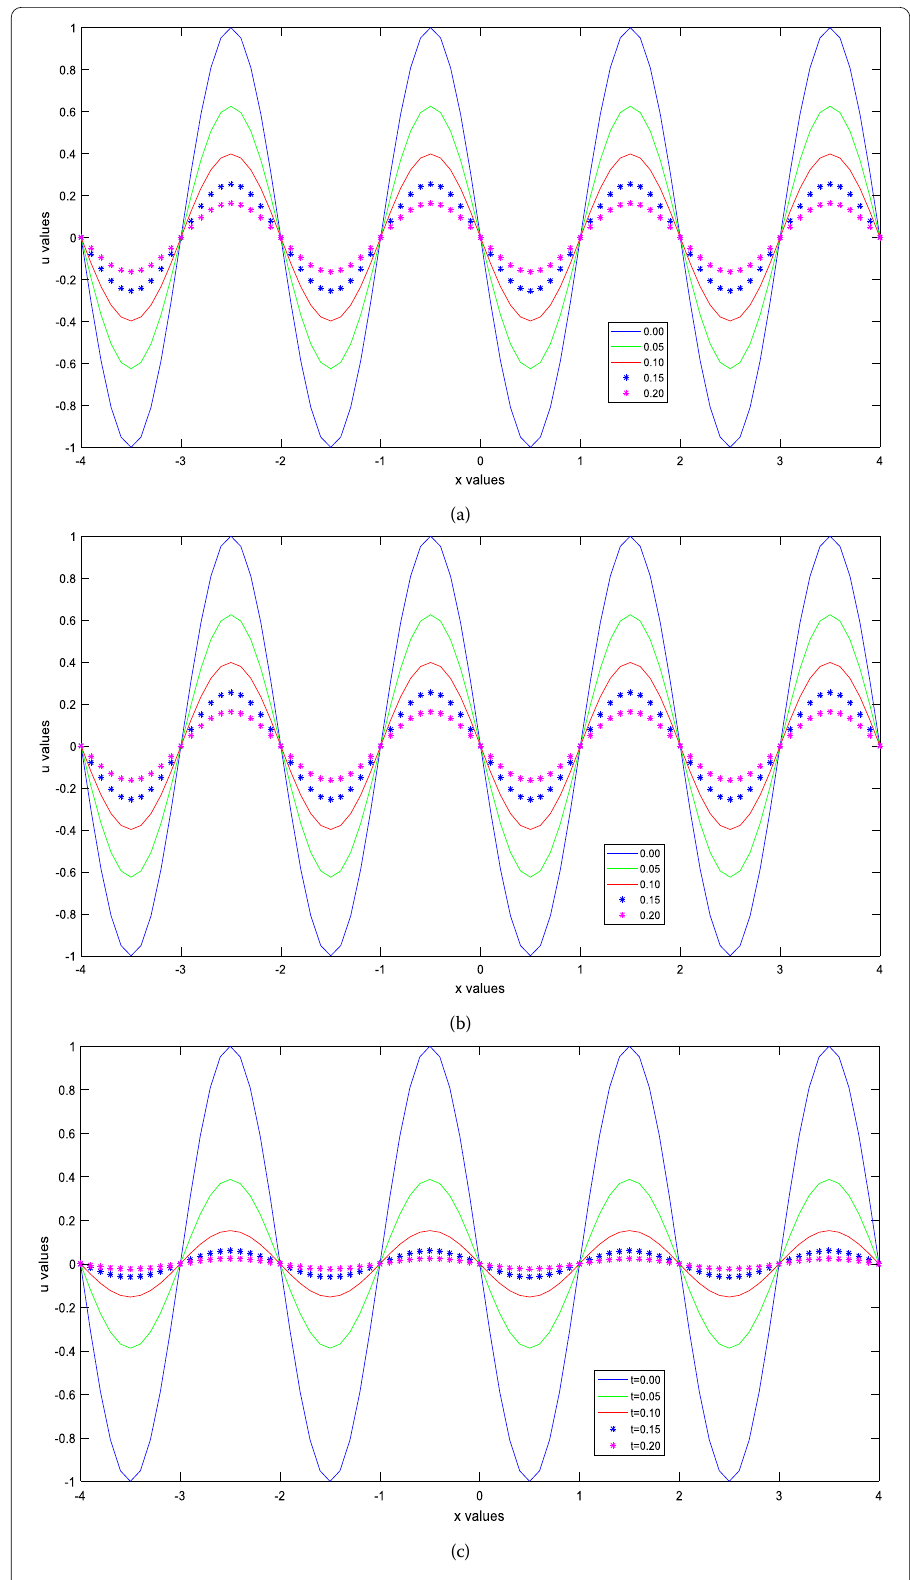
Figure 4 Example 4: ( a ) The profiles of u ( x , t ) versus x for γ = 0. ( b ) The profiles of u ( x , t ) versus x for γ = 0.0001. ( c ) The profiles of u ( x , t ) versus x for γ =